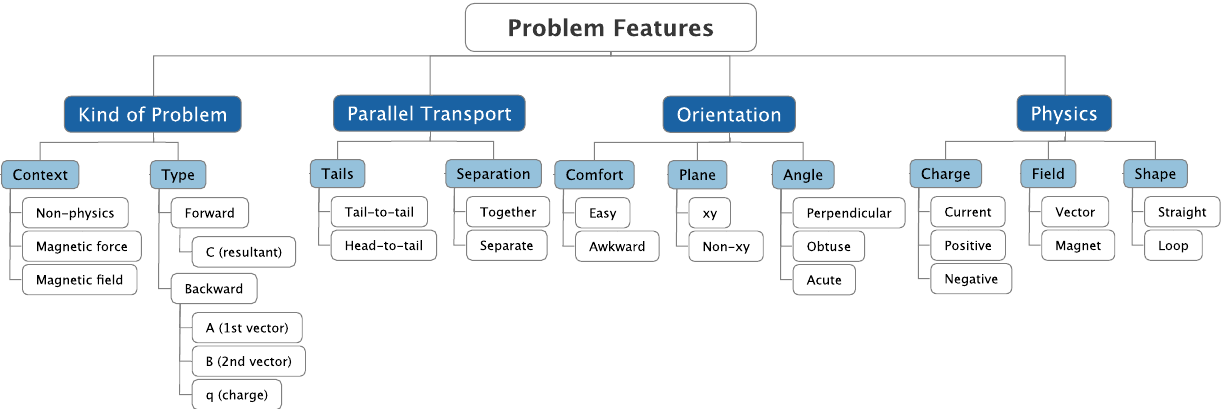
FIG. 1. Overview of the problem features identified from the literature and used in this study as predictors of performance. Individual features are in light blue (single quotations in text), with the variations beneath in white (italics in text). The features are grouped into larger categories (dark blue) to facilitate discussion in the text. See Table I for the hypothesized impact of each feature on